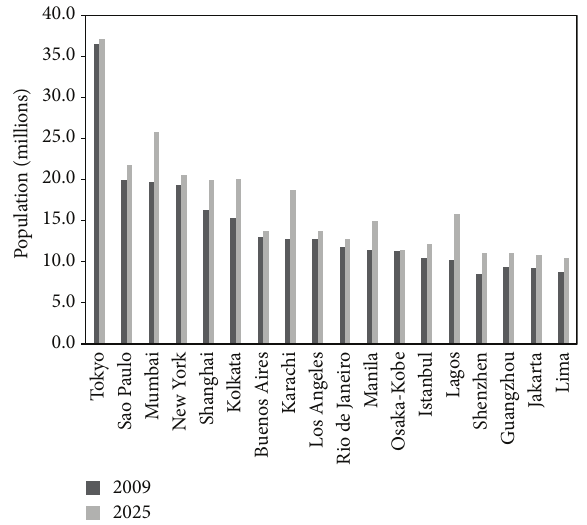
Figure 1: Identified seventeen megacities in the coastal zone (MCCZ) in the study and their population in 2009 and 2025,